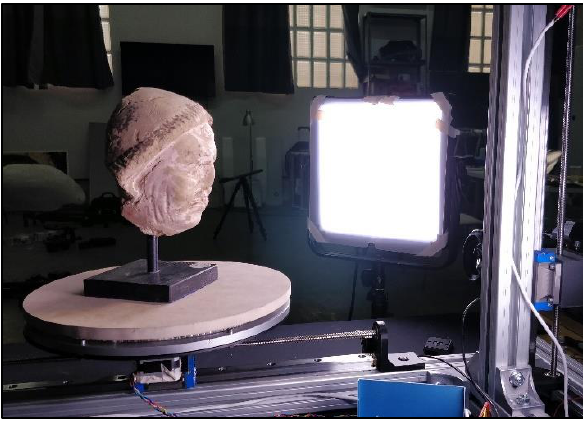
Figure 10. Artefact being